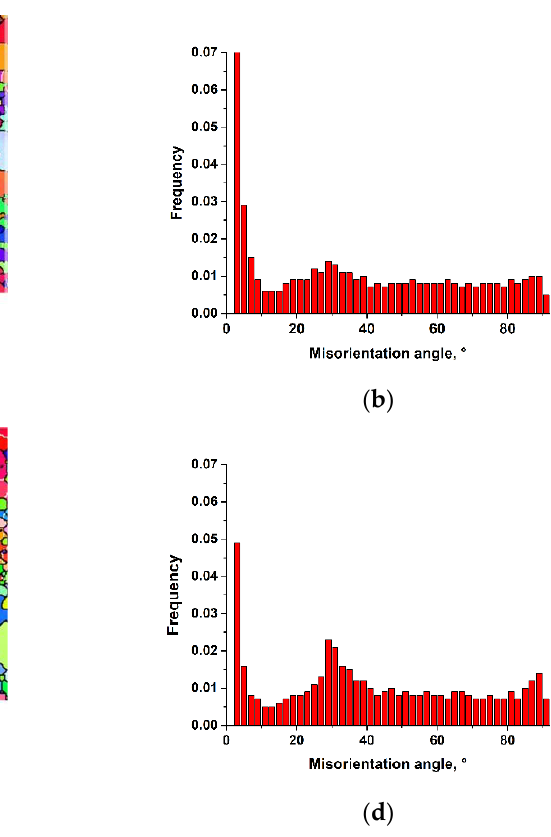
Figure 3. Maps and histograms of misorientations in the Mg-Al-Zn alloy after deformation processing ( a , b ) and post-deformation ultrasonic treatment ( c , d ). Table 1. XRD results.